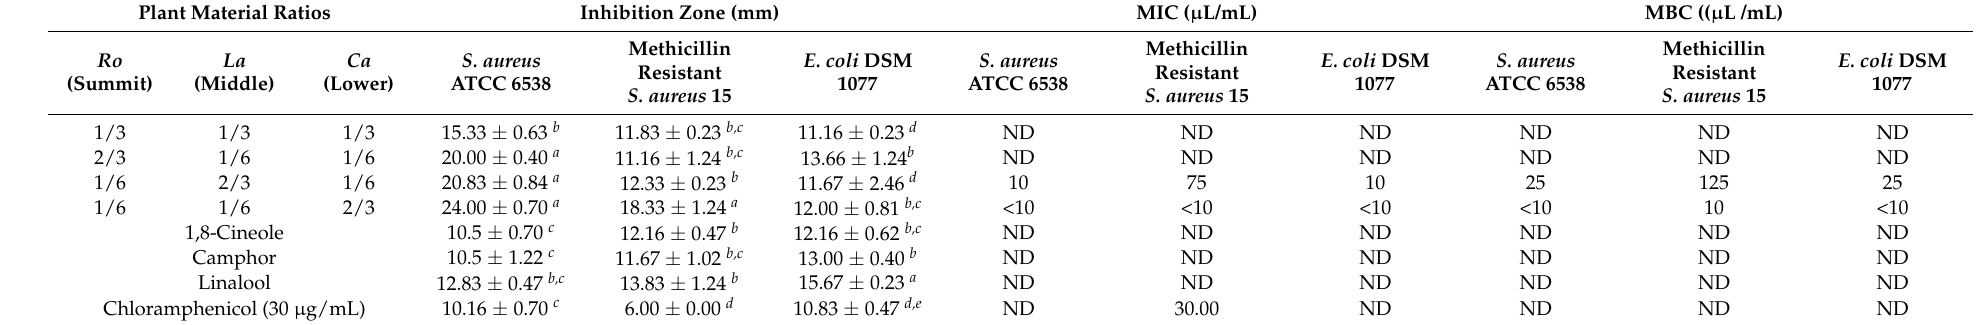
Data represent mean ± standard deviation. ND—not determined. Values in the same column followed by the same superscript letter are not significantly different ( p > 0.05) by Tukey’s